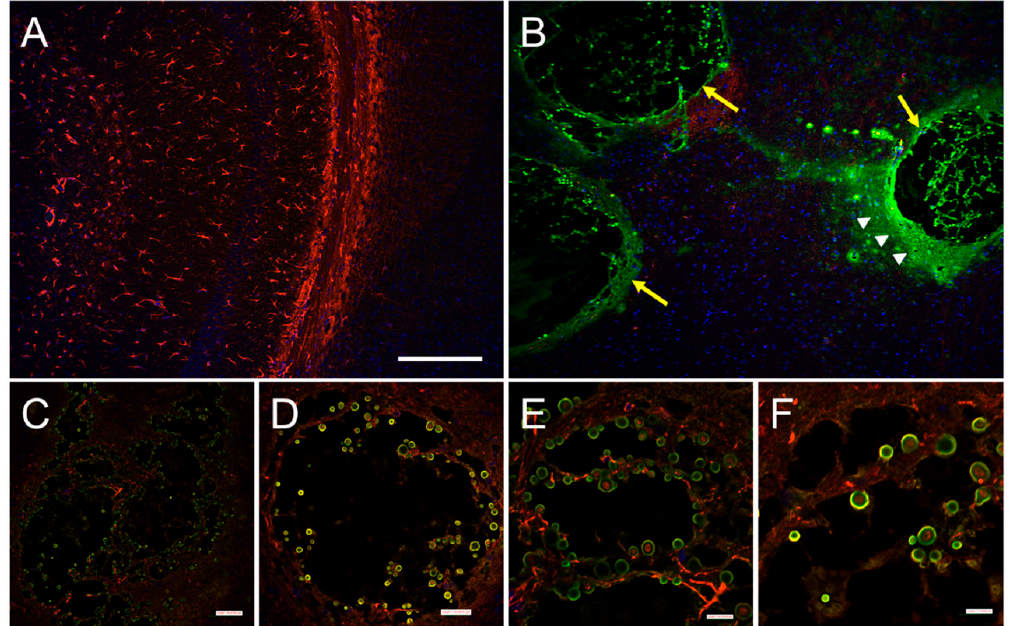
Figure 1. Biofilm-like cryptococcomas (brain lesions) in hippocampal tissue sections 14 days after intratracheal inoculation of C. neoformans strain H99 in a C57BL/6J mouse. ( A ) Confocal microscopy of the hippocampus in the brain of an infected animal with cap59 (acapsular mutant). Capsule deficient mutants are cleared by phagocytic cells in the lungs of infected animals and are unable to reach the central nervous system; ( B ) Immunofluorescent image of a hippocampal tissue section of a mouse infected with wild-type C. neoformans H99 displaying large cryptococcomas (yellow arrows) filled with yeasts cells and abundant amounts of capsular polysaccharide released (white arrow heads) in the area; ( C , D ) Cryptococcomas are characterized by significant neuronal loss due to biofilm-like colonization of brain tissue; ( E , F ) High magnification images show a substantial number of yeast cells attached to neuronal tissue. For panels A – F , capsular-specific monoclonal antibody 18B7 (monoclonal antibody 18B7; green) was used to label fungal cells and capsular polysaccharide released. GFAP (red) and DAPI (blue) staining were used to label the cell bodies and nuclei of astrocytes, respectively. Scale bars: A,B = 230 µm; C = 87 µm; D = 35 µm; E = 21 µm; F = 17 µm.